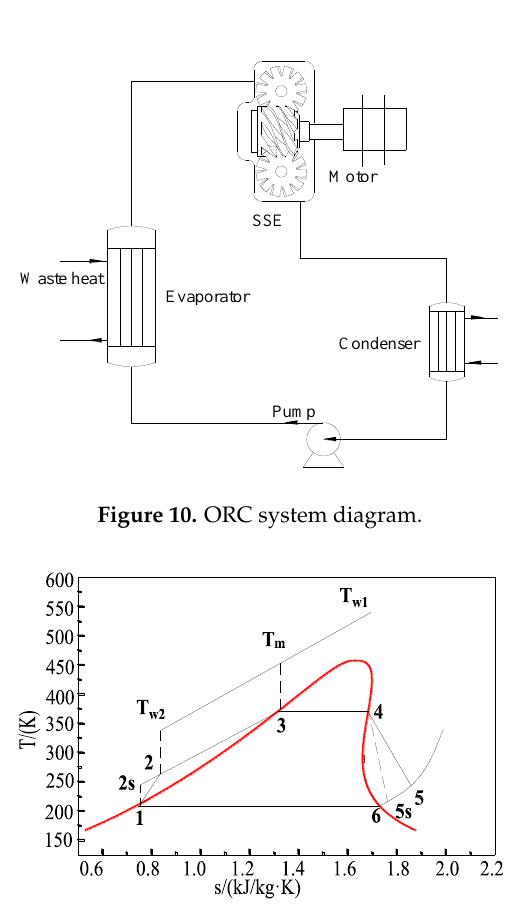
Figure 11. T-s diagram of the ORC system.